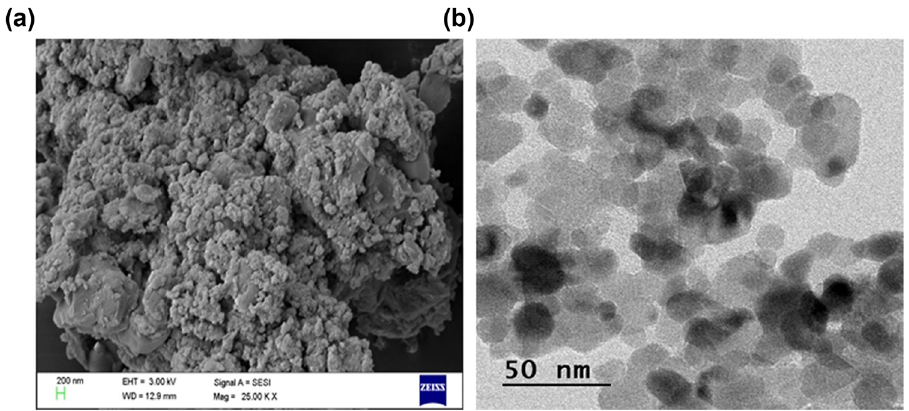
Figure 3: SEM and TEM analyses of ZnONPs - NC: ( a ) SEM microscopic image shows the structure and morphology of the ZnONPs - NC; ( b ) TEM microscopic image shows the size and clear morphology of the synthesized ZnONPs - NC.